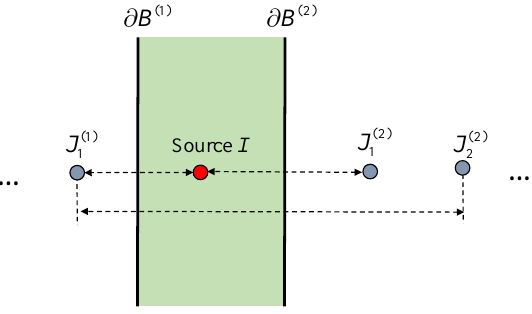
( 1 ) is added by mirroring 1 ( 2 ) is added by mirroring the 1 ( 2 ) is added by mirroring image source 2 ( 2 ) denotes the order of the image source, and the 2